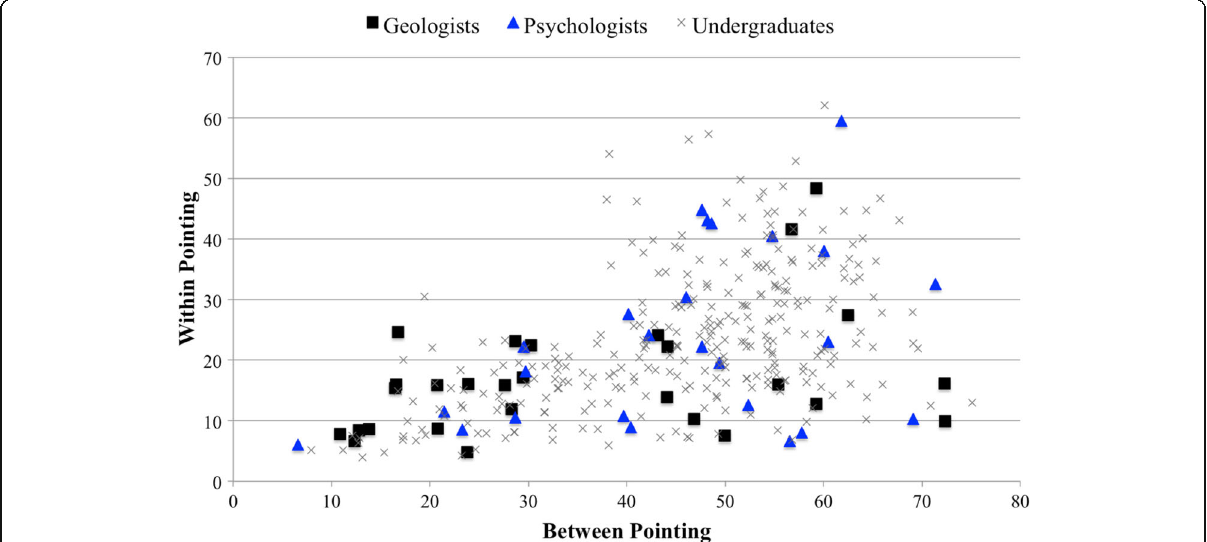
Fig. 4 Scatterplot of performance on between-route and within-route pointing trials grouped by geologists and non-STEM undergraduates. Quadrants are based on cluster membership cutoff values — good between/good within (integrators), good between/bad within (non-integrators) and bad between/bad within (imprecise navigators) — established in previous studies using Virtual Silcton (Weisberg & Newcombe,